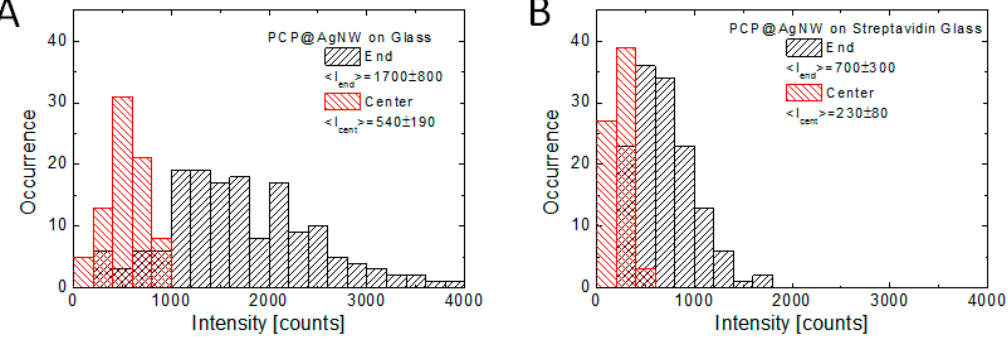
Figure 5. Histogram of fluorescence intensity of PCP complexes conjugated to the ends and centers of AgNWs (black and red bars, respectively) for the bare glass ( A ) and streptavidin-covered glass ( B ) substrates.